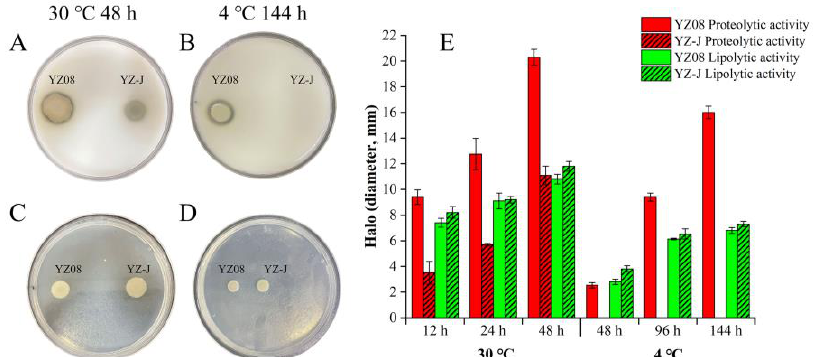
Figure 8. Halos associated with proteolytic (measured on agar plates containing 5% skimmed milk) ( A , B ) and lipase (measured on triglyceride agar) ( C , D ) activity of Shewanella putrefaciens YZ08 and YZ-J following incubation at 4 and 30 °C for 48 and 144 h. Bars in the graphs represent the mean diameter of clear proteolytic and lipolytic halos at 30 °C for 12, 24, and 48 h and 4 °C for 48, 96, and 144 h ( E ).